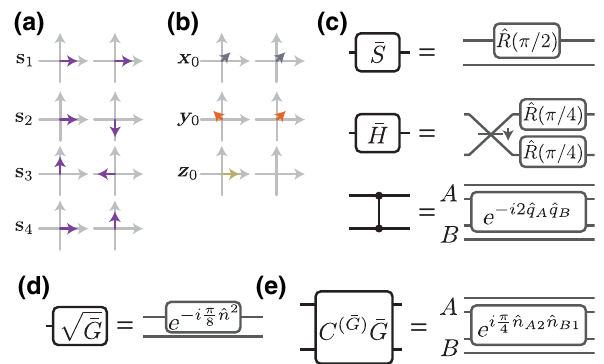
FIG. 10. D 4 code. (a) Phase-space representation of the stabi- lizer generators. The left and right graphs represent the projection onto the ( q , p ) phase space of the first and second mode, respec- tively. (b) Similar representation for the logical operators. (c) Logical Clifford operations in the D 4 code. The